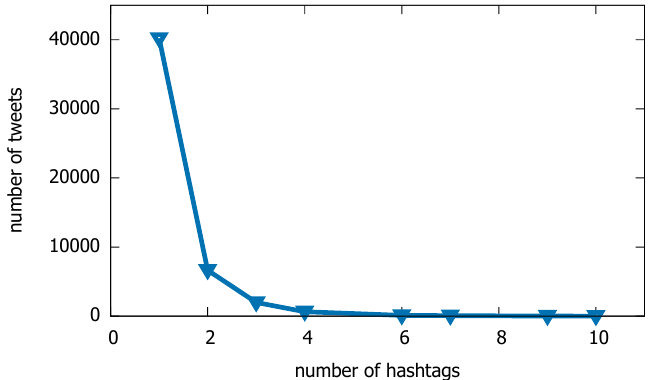
Figure 10. The distribution of the number of hashtags for each